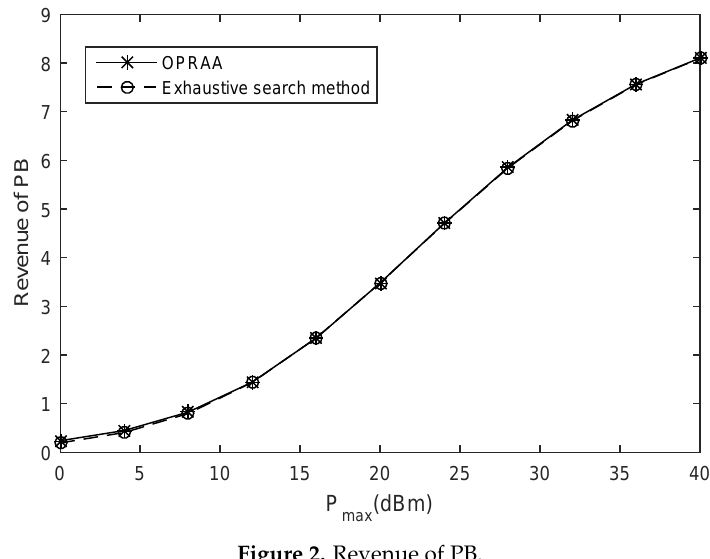
Figure 2. Revenue of